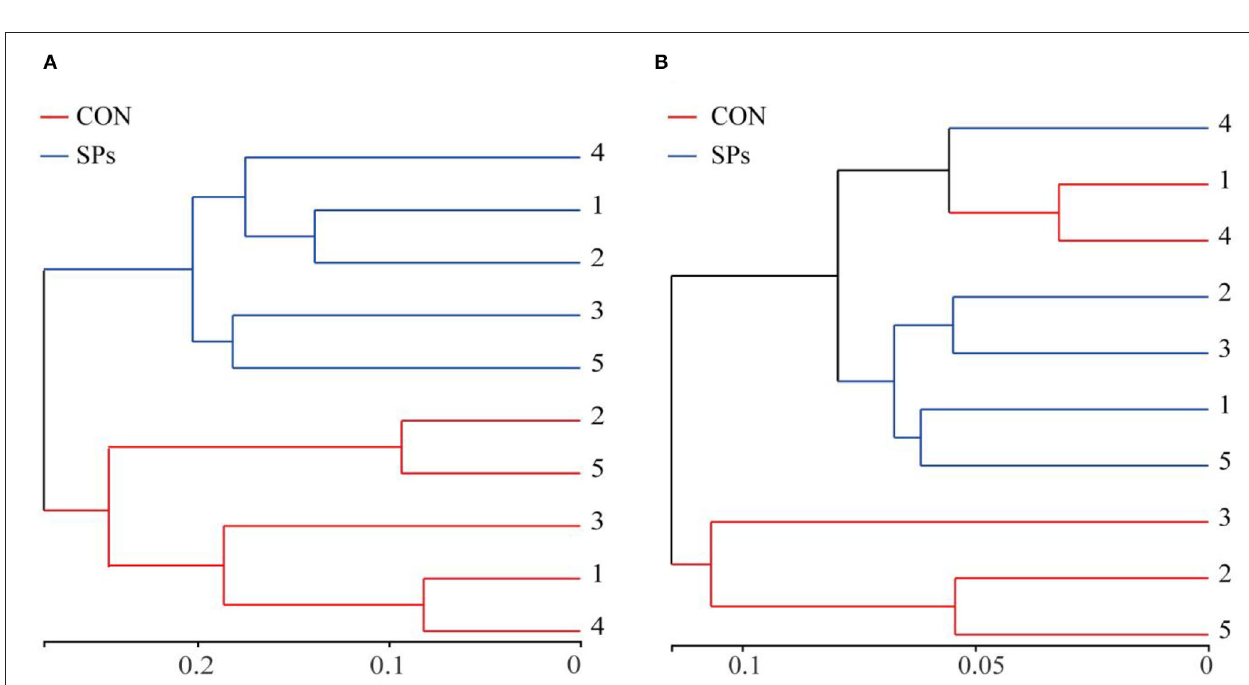
FIGURE 2 | Effects of the dietary supplementation of soybean peptides (SPs) on beta-diversity according to OTU levels. (A) PCoA of ruminal bacteria based on the Bray–Curtis distance. (B) PCOA of ruminal bacteria based on Binary Jaccard distance. CON, the control group with no soybean peptide supplementation; SPs, the group with 50 g/head/day of soybean peptide supplementation.